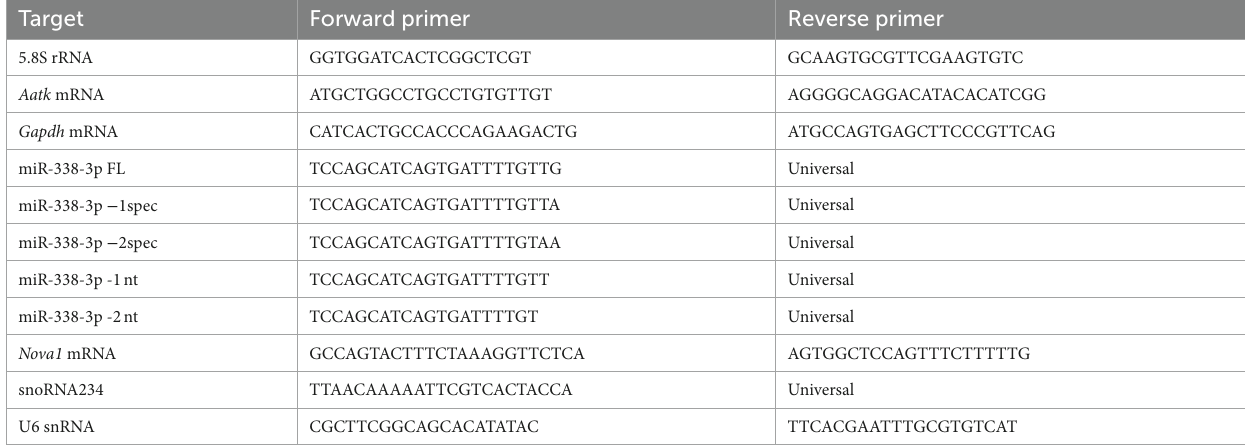
TABLE 2 RT-qPCR primer sequences shown 5 ′ –3 ′